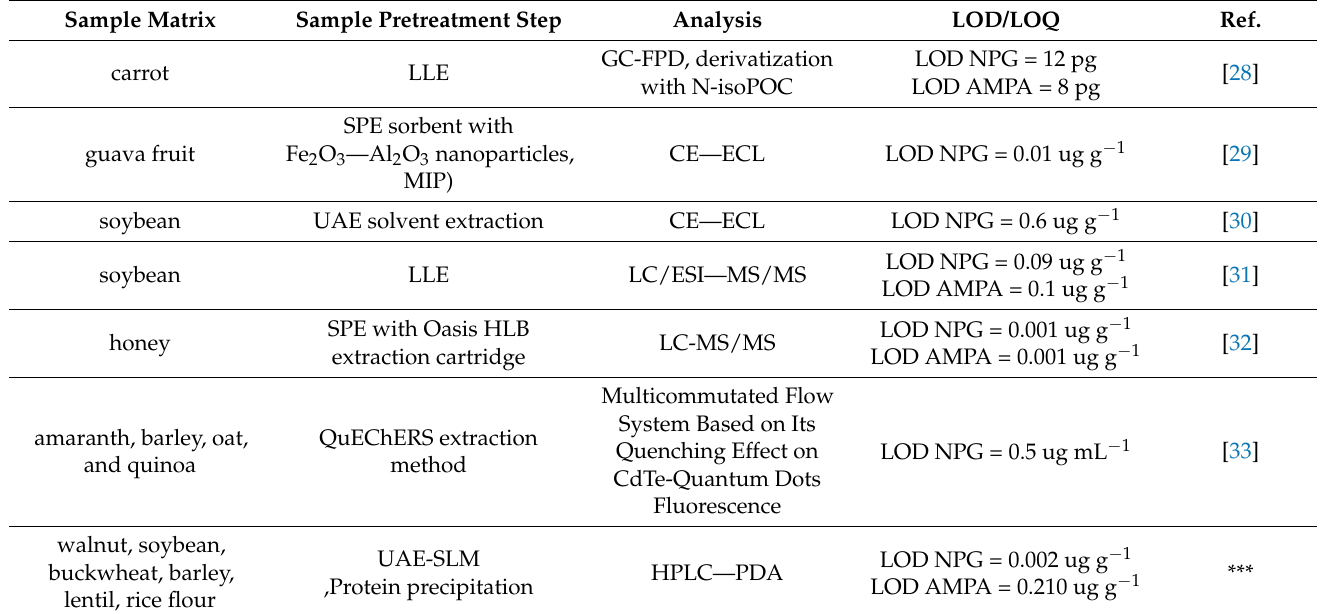
Table 4. Analytical performance of the developed analytical procedure compared to the other methods used for the determination of NPG and AMPA in food